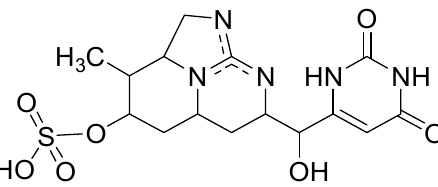
Figure 1. The structure of cylindrospermopsin (CYN).